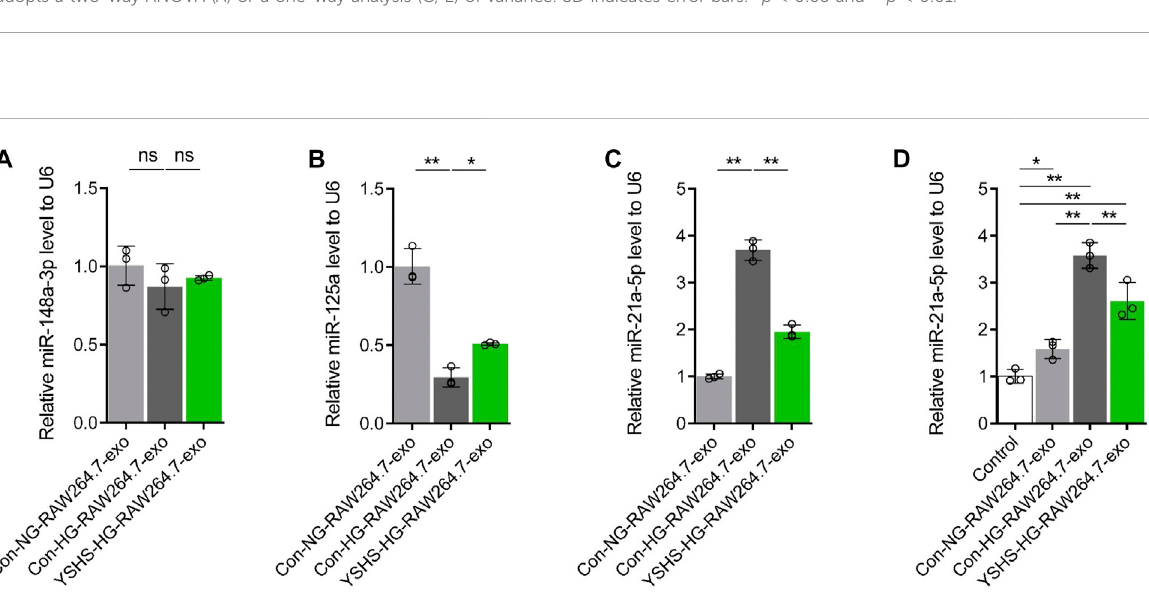
FIGURE 5 Effect of exosomes secreted by macrophages treated with HG and (or) YSHS on podocyte MPC5 cell injury. (A) Measurement of the activity of MPC5 cells treated with different kinds of macrophage-derived exosomes (25 μ g/ml) by CCK8. (B) Western Blot was used to detect the caspase-3 cleavage of podocyte MPC5 cells in each treatment group. (C) Measurementof thelevel ofapoptosis ofMPC5 cells by fl ow cytometry.Data analysis adopts a two-way ANOVA (A) or a one-way analysis (C, E) of variance. SD indicates error bars. * p < 0.05 and ** p < 0.01.